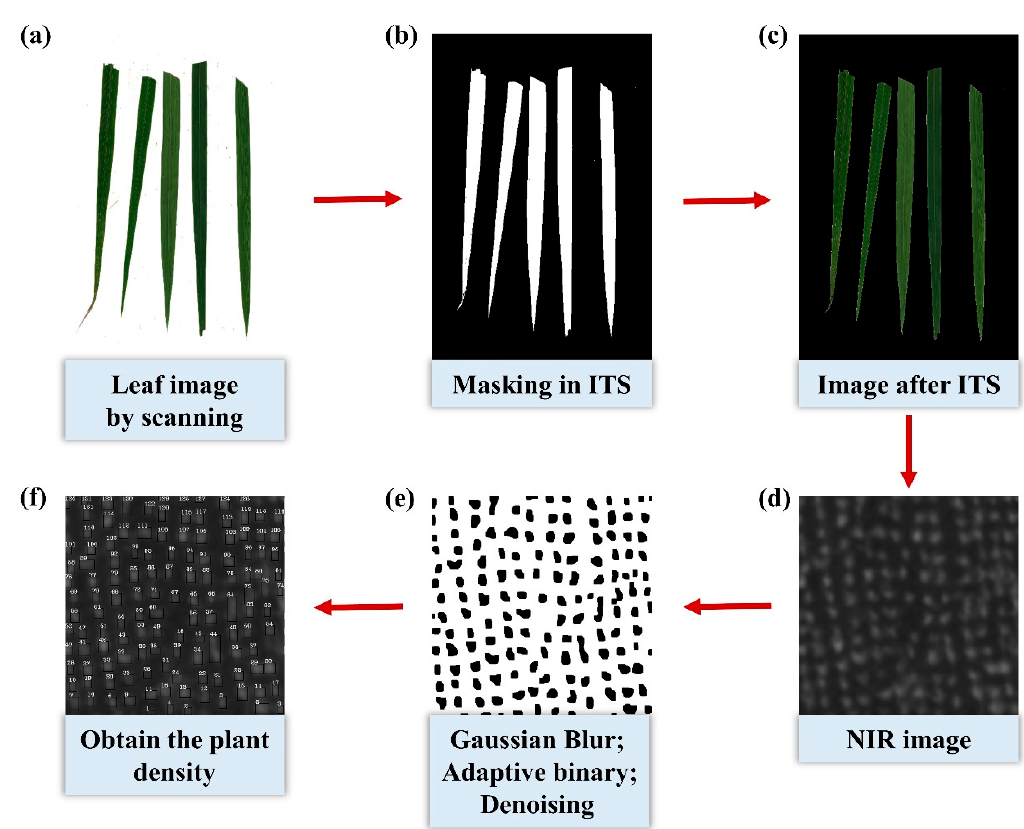
Figure 2. Framework for determining rice leaf area of a single plant (LAS) and plant density (PD) from the multispectral images. ITS indicates image threshold